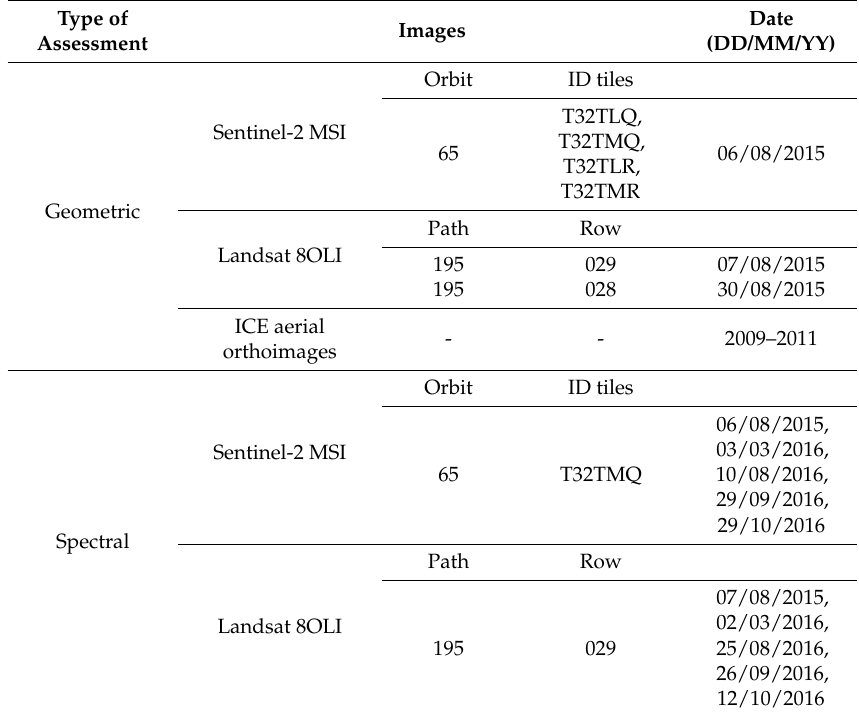
Table 1. List of images used for geometric and spectral assessments.